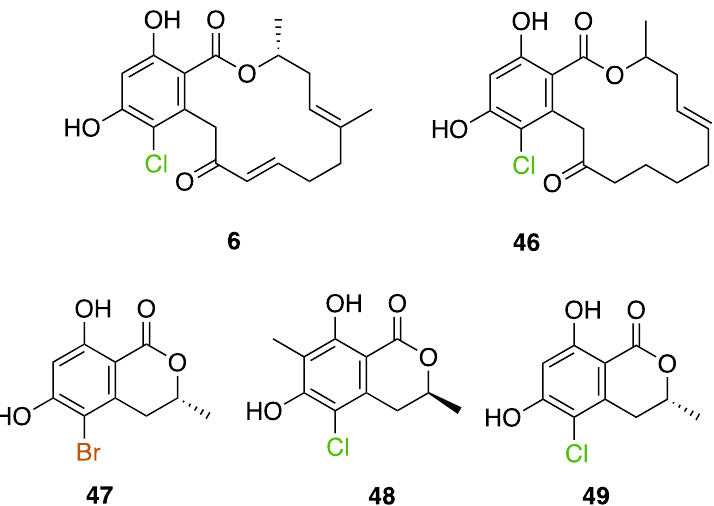
Figure 25. Structures of the metabolites found in the pochonin D cluster 1: pochonin D ( 6 ), monorden E ( 46 ), palmerin D ( 47 ), chaetosemin G ( 48 ), and 5-chloro-6-hydroxymellein ( 49